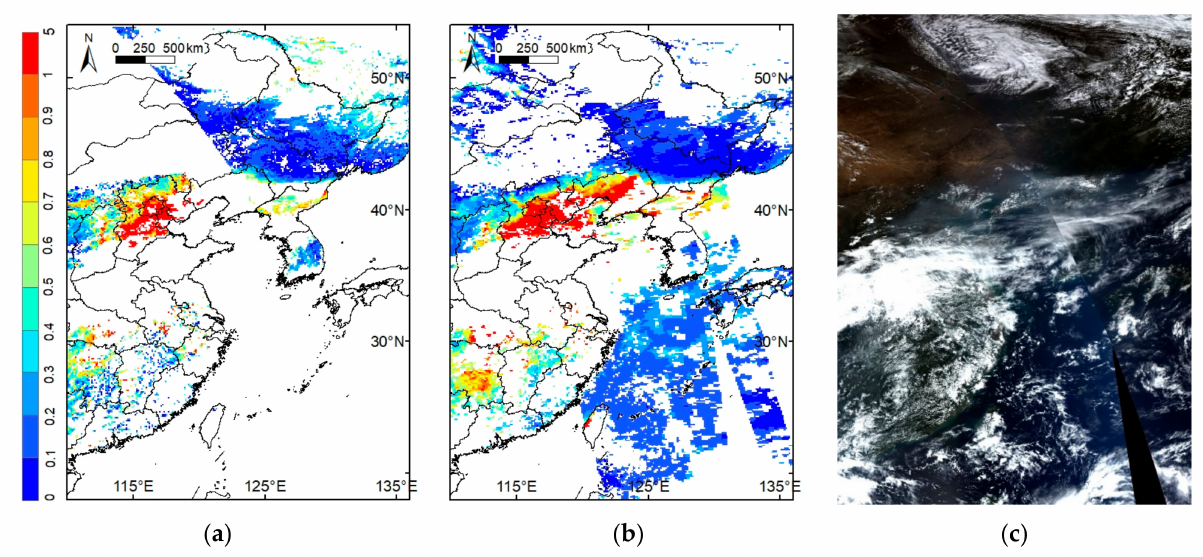
Figure 19. AOD maps over Eastern Asia on 24 September 2009: ( a ) NP AVHRR AOD; ( b ) AQUA MODIS Dark Target and Deep Blue AOD product; ( c ) RGB composite image of MYD02 data with a spatial resolution of 1 km.